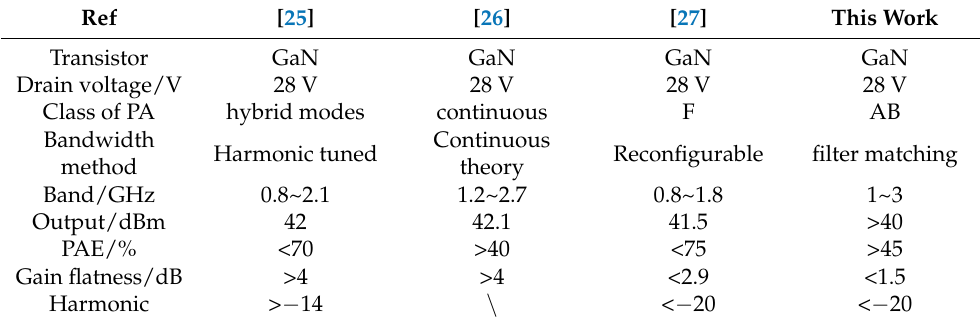
Table 2. Performances compared with PA proposed in other